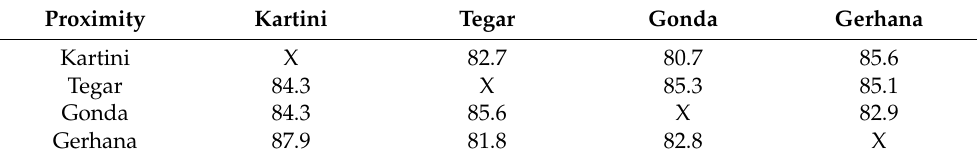
Table 4. Percent of scans infants spent in proximity of one another (within 0–10 m).